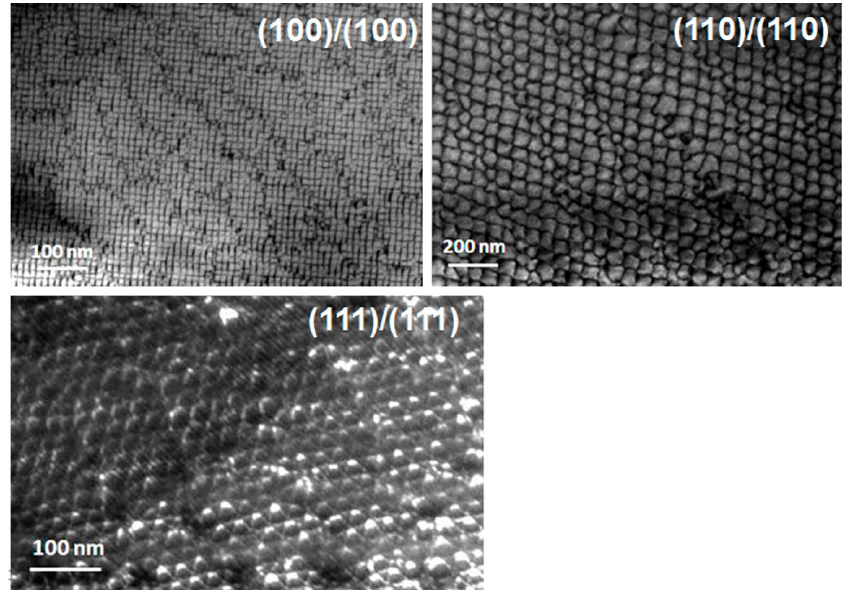
Figure 3. Transmission electron microscopic images of dislocation networks formed by wafer bonding of wafers with different surface orientation indicated in the figures.